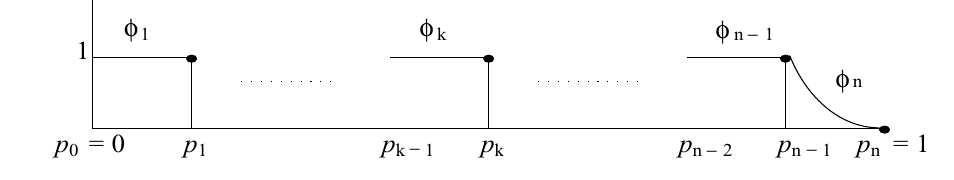
Fig. 1. Constant shape functions on unit interval η ∈ [0 , 1]